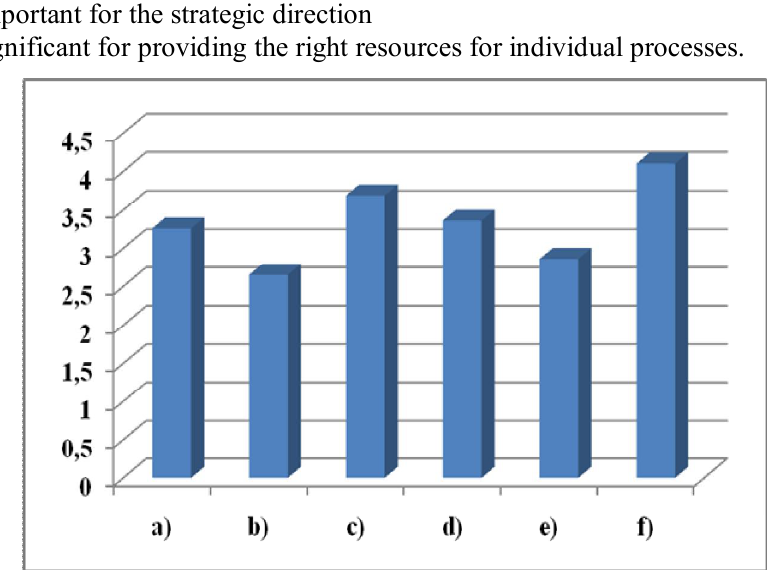
Figure 1 - Graphical representation of responses to question no.